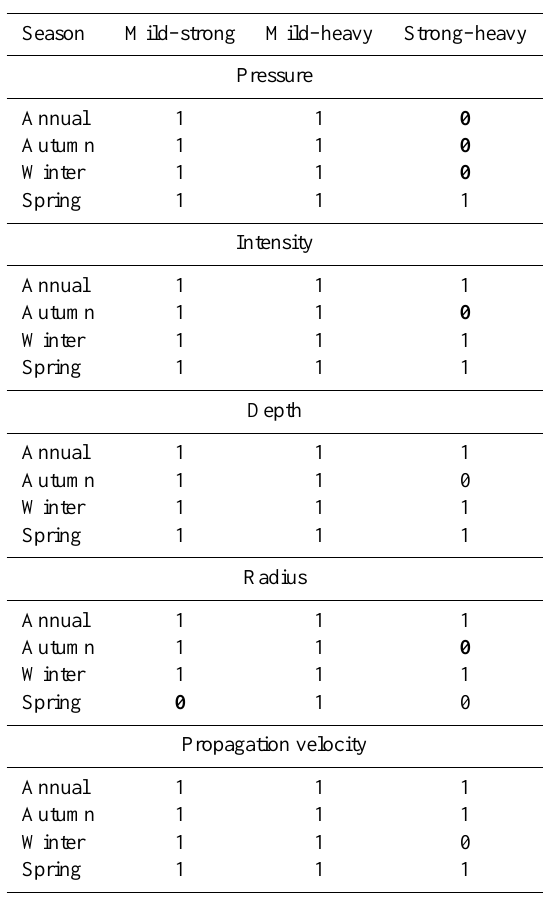
Table 3. Statistical significance results for the characteristics of “af- fecting” cyclones concerning the different rain categories. The sta- tistical significant differences at 5% significant level are denoted by 1. The zero values denoted in bold font are those not significant in neither 1, 5 nor 10% significant levels and zero values which were not noted are significant at 10% significant level.